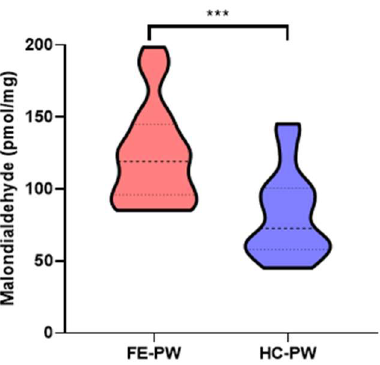
Figure 5. Malondialdehyde (MDA) levels, in pmol/mg, found in the placental tissues of both the FE-PW and HC-PW groups. FE-PW = first psychotic episode during pregnancy. HC-PW = healthy controls pregnant women. p < 0.001 (***).